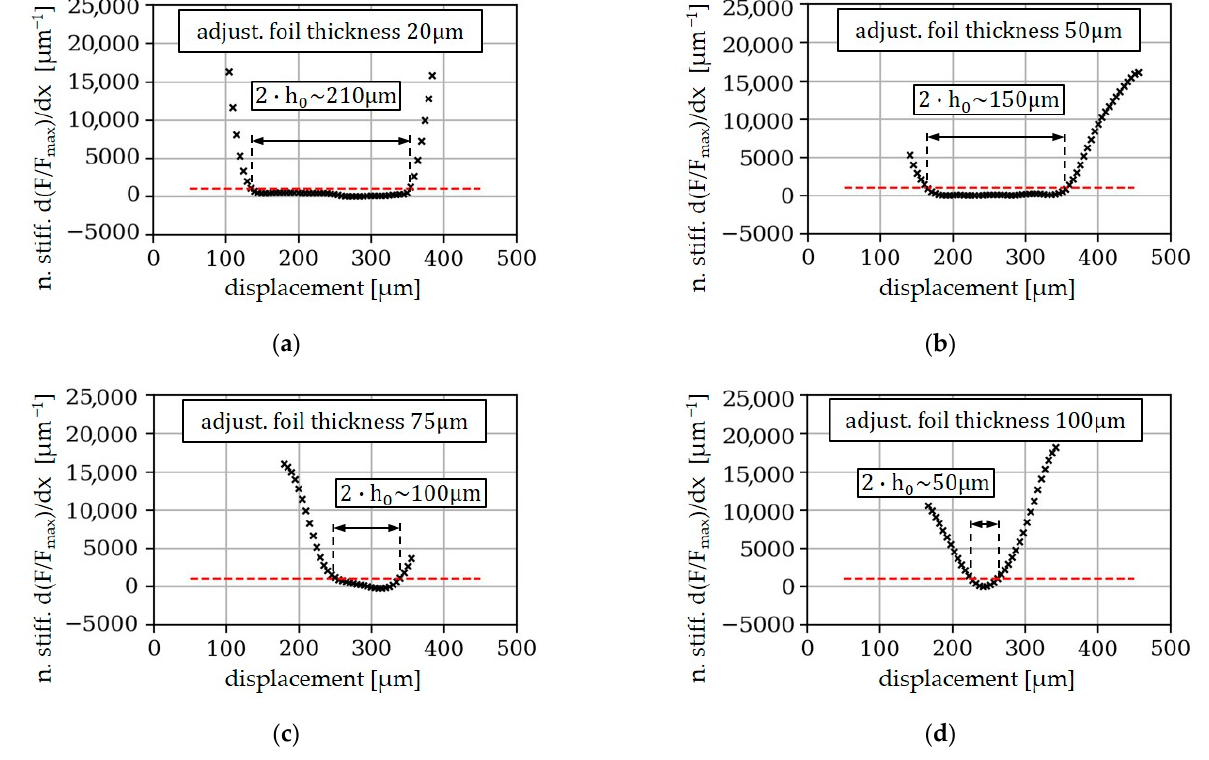
Figure 5. Results of the gap measurement for the GPB with adjustment foil at 60°–240°; position- dependent normalized stiffness (black crosses); threshold level (red dashed line); and adjustment foil thickness ( a ) 20 µm; ( b ) 50 µm; ( c ) 75 µm; ( d ) 100 µm.